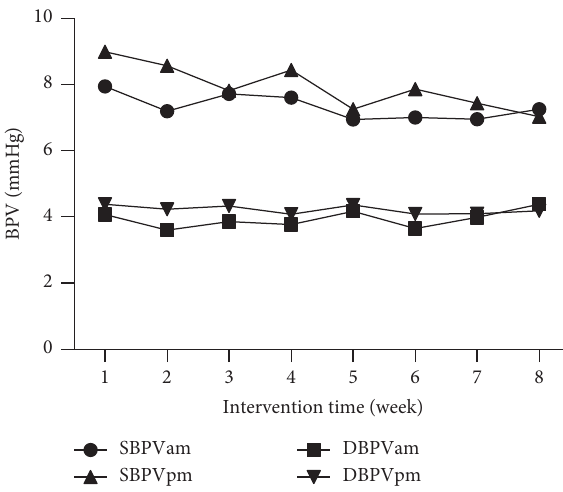
Figure 2: Weekly BPV change trend of patients. Table 4: Weekly changes in systolic blood pressure